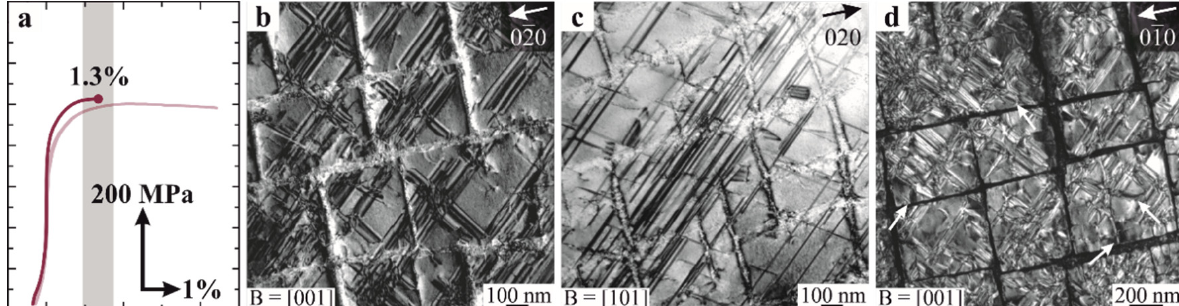
Figure 4. Defect structures in VF60 after compression tests at 1000 ◦ C and a strain-rate of 1 · 10 − 4 s − 1 interrupted at a plastic strain of 1.3%. The interrupted stress-strain curve are shown in ( a ). All TEM micrographs were taken in two-beam conditions close to the ( b , d ) [001] or ( c ) [101] zone axis and with ( b ) g = 0–20 (CDF), ( c ) g = 020 (BF) and ( d ) g = 0–10